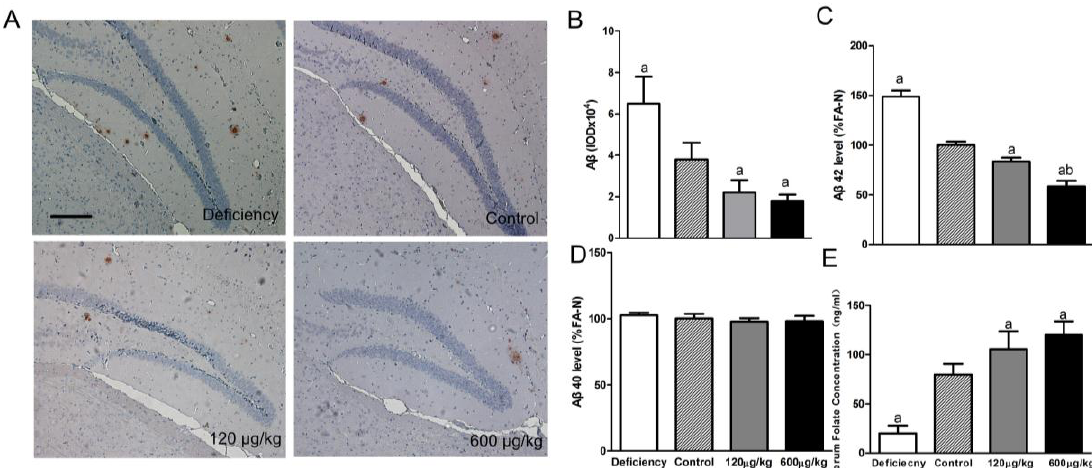
Figure 1. Folate reduced hippocampal amyloid plaque loads in APP/PS1 (amyloid precursor protein)/(presenilin 1) mice. With bam-10 immunohistochemical staining following the administration, compared with the control group, the deposition of Aβ was significantly decreased in both 120 μg/kg and 600 μg/kg groups ( A , B ); scale bar = 100 μm. Enzyme-linked immuno sorbent assay (ELISA) was used to measure Aβ levels in brain tissues. Compared with the control group, folic acid administration decreased Aβ42 deposition, but not Aβ40 ( C , D ). The Aβ42 level was further decreased in the 600 μg/kg group compared to the 120 μg/kg group. After eight weeks, the folate deficiency diet reduced serum folate. Folic acid administration increased serum folate compared with the control group ( E ). The data were expressed as means ± SD values, n = 6 animals/group. a: p < 0.05 versus the Control group; b: p < 0.05 versus the 120 μg/kg group.